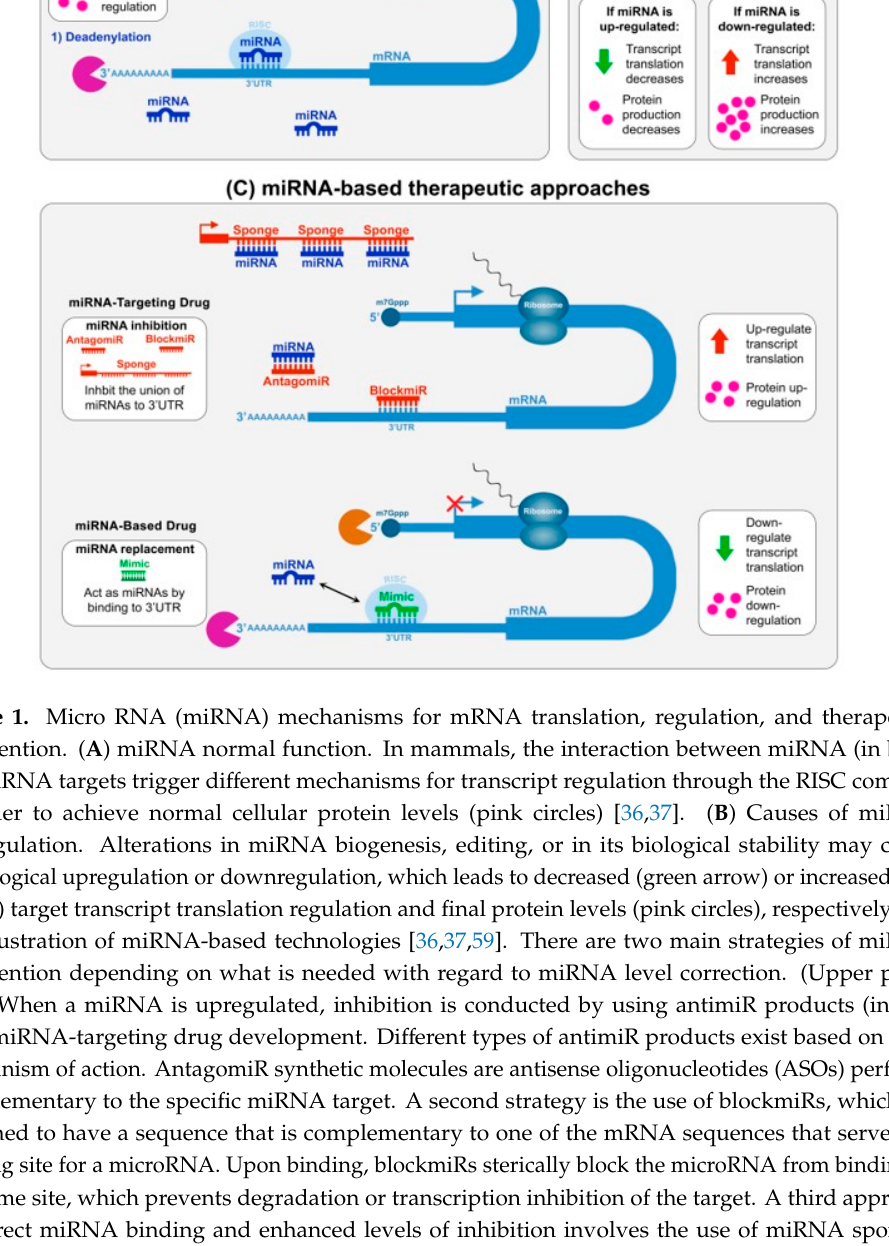
arrow) target transcript translation regulation and final protein levels (pink circles), respectively